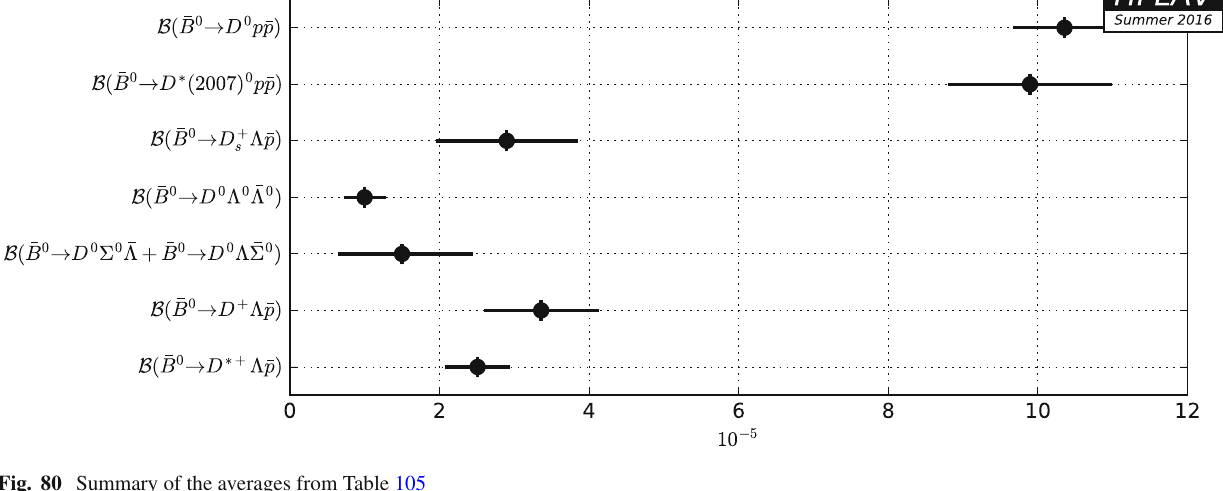
Fig. 80 Summary of the averages from Table 105